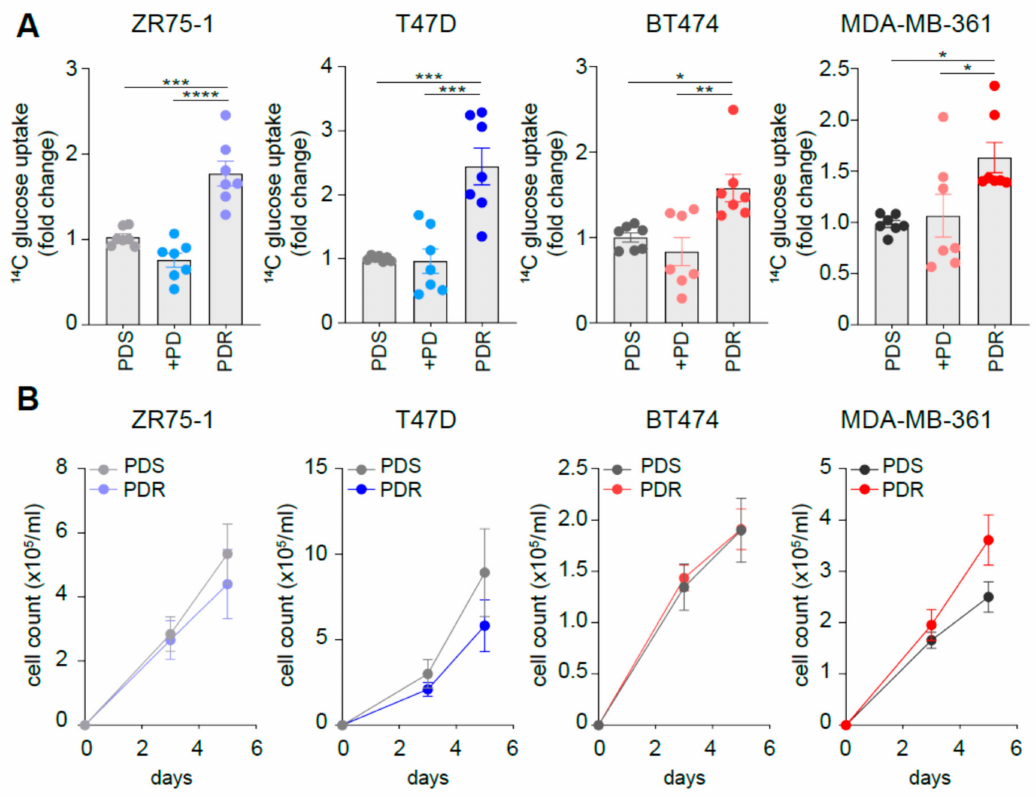
Figure 2. Resistant cells show comparable growth rates when compared to sensitive counterpart while increasing glucose uptake. ( A ) 14 C-glucose uptake was measured in PDS (either in presence or absence of 1 µ M palbociclib, PD) and PDR cells. The relative uptake capacity is shown using PDS cells as comparator. Each dot represents a biological replicate. Gray shades are used for PDS cells, blue shades when PD is administrated to HER2 − cells (either PDS or PDR), red shades when PD is administrated to HER2 + cells (either PDS or PDR). Data represent means ± SEMs. One-way ANOVA; Dunnett corrected; * p < 0.05; ** p < 0.01; *** p < 0.001; **** p < 0.0001. ( B ) No significant reduction in cell survival between PDS and PDR derived cells was observed by cell counting within the 5-day time range. Data represent means ± SEMs. Two-way ANOVA; Bonferroni